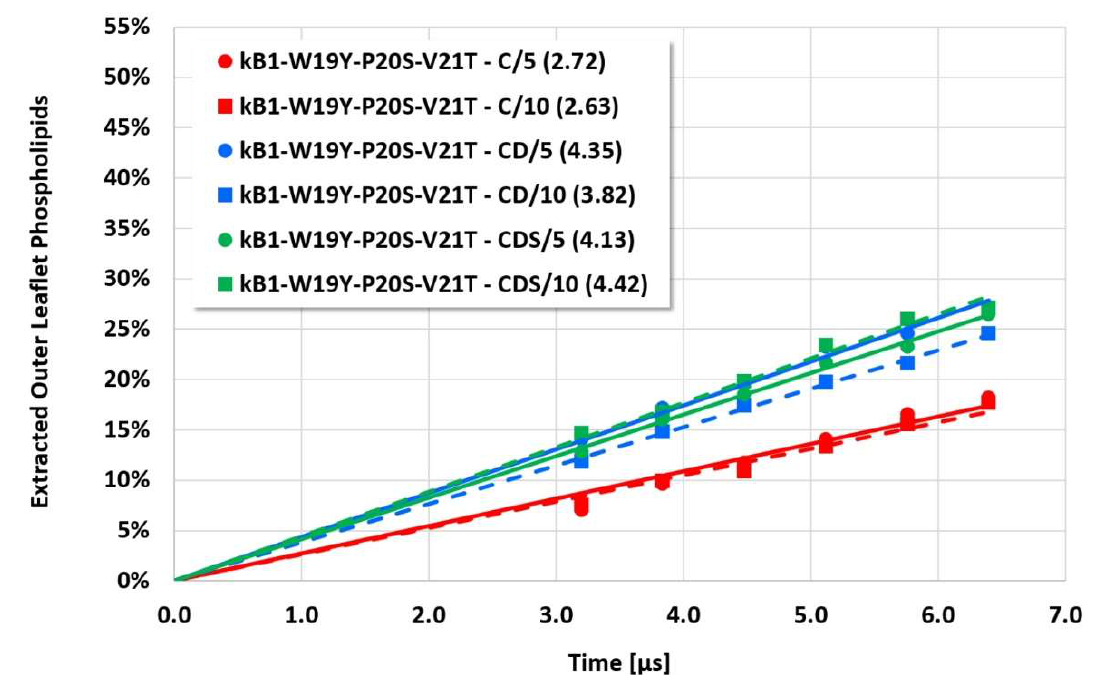
Figure 5. Cyclotide/membrane system kB1-W19Y-P20S-V21T/NoC-PM (see Figure 4 for details).